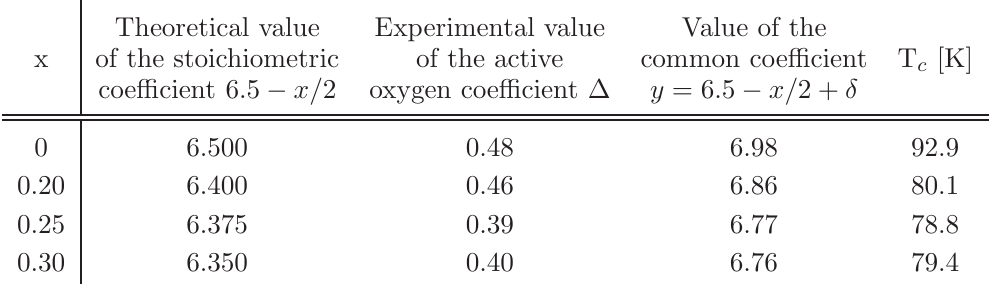
Table 2 Results for the oxygen coefficient in Eu 1 − x Ca x Ba 2 Cu 3 O y